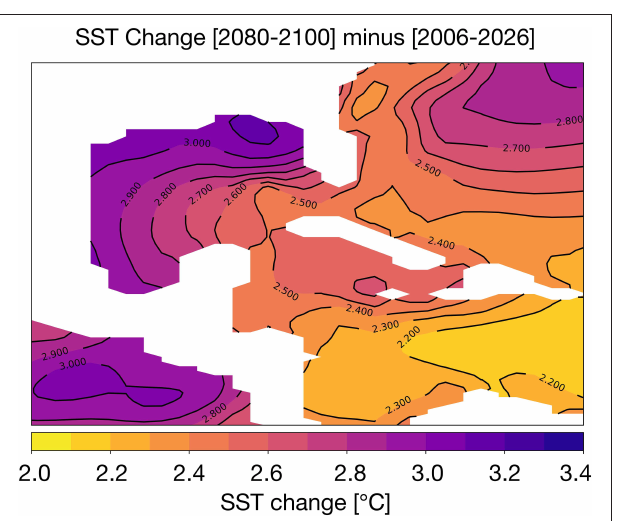
FIGURE 3 | Simulated changes in Gulf of Mexico SST [ ◦ C] in the RCP8.5 Large Ensemble, CESM1.2. (2080–2100 mean minus 2006–2026 mean). Continental regions are shown in